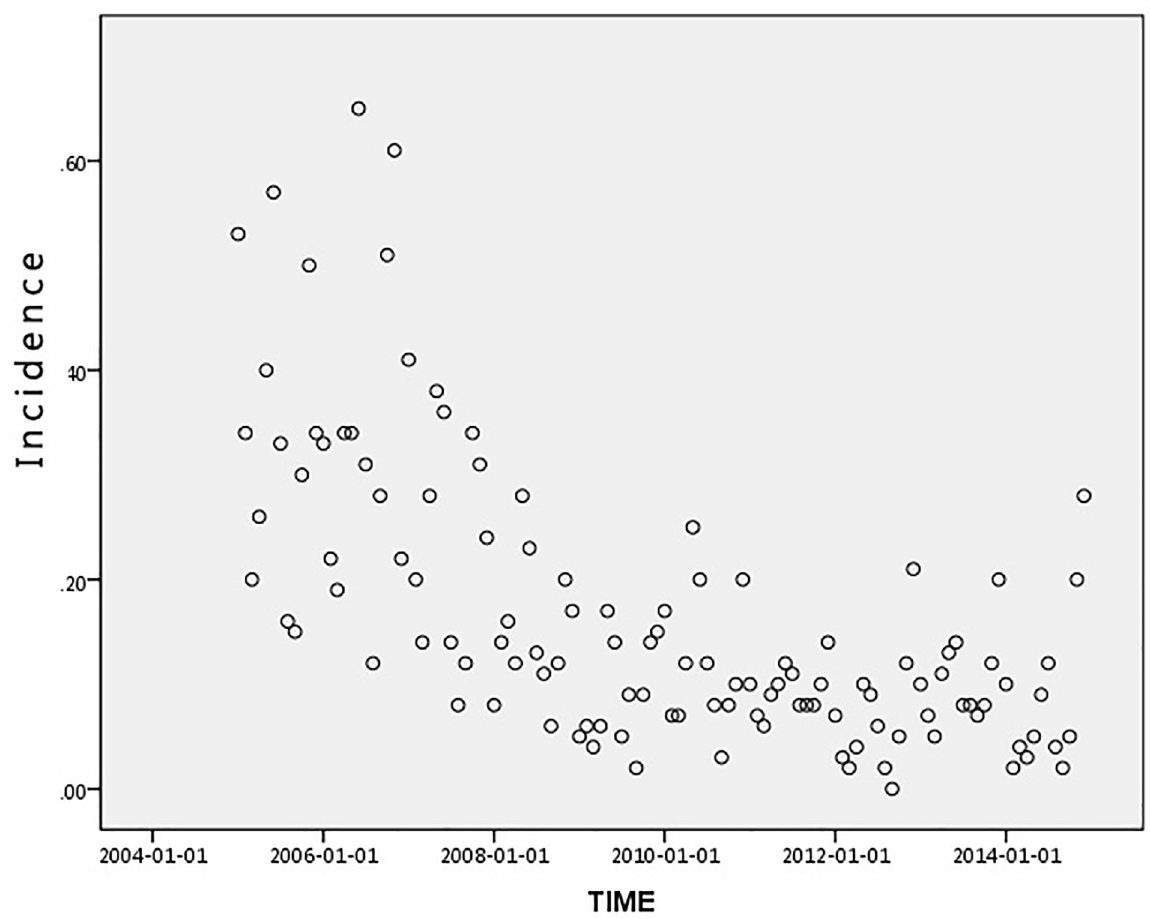
Fig 2. Scatter distribution of the HFRS incidence in Hubei Province from 2005 to 2014. Each plot shows the incidence of HFRS for a unique date.